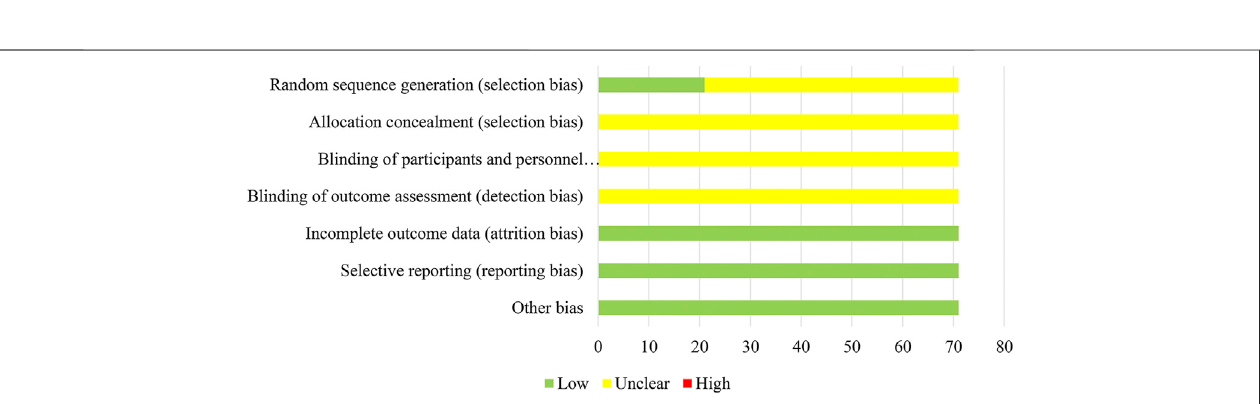
FIGURE 4 | Assessment of risk